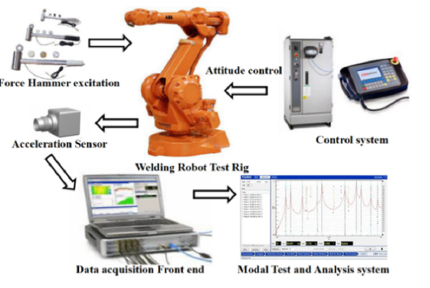
Figure 2. Experimental system for verification. A comparison of the first seven natural frequencies between the simulation and tests is shown in Table 1. Table 1. Comparison of the first seven natural frequencies between the simulations and tests. Order Simulation Result (Hz) Experimental Result (Hz) Error Rate